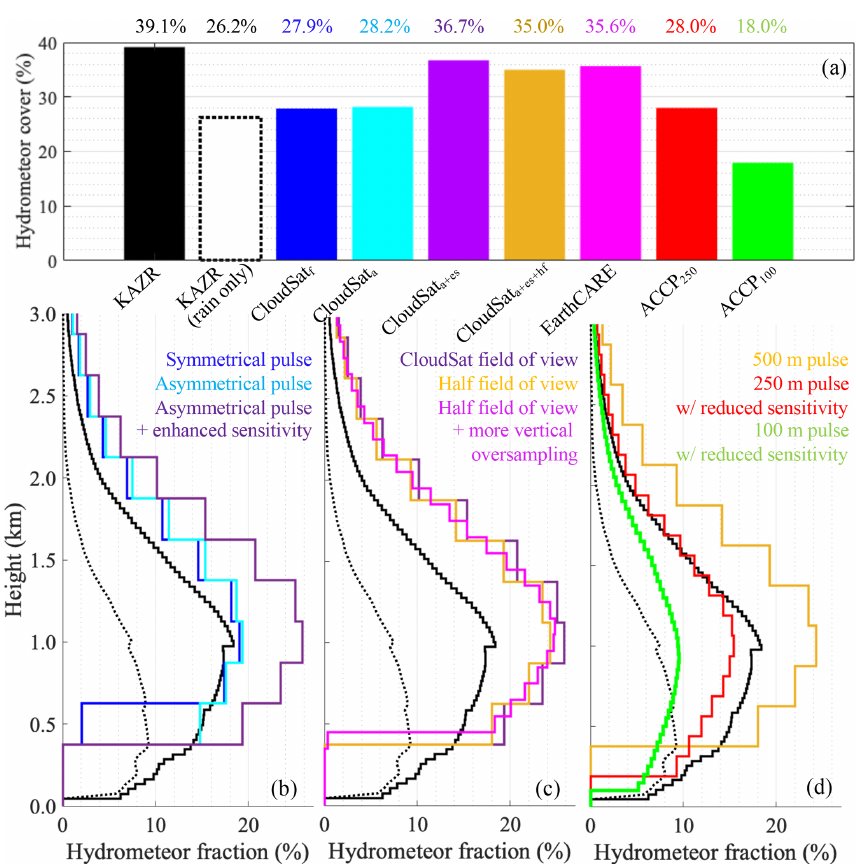
Figure 7. For 719 forward-simulated days, (a) fraction of observed profiles containing either cloud or rain (i.e., hydrometeor cover); also, for the KAZR only, using complementary ceilometer observations, we estimate the fraction of all observed profiles containing rain in the subcloud layer. (b–d) Hydrometeor fraction profile estimated for all the forward-simulated radar architectures. All acronyms and colors are defined in Fig. 6 with the exception of CloudSat nps + es + hf which is the CloudSat CPR operating with EarthCARE’s asymmetrical range- weighting function, enhanced sensitivity and half the horizontal field of view